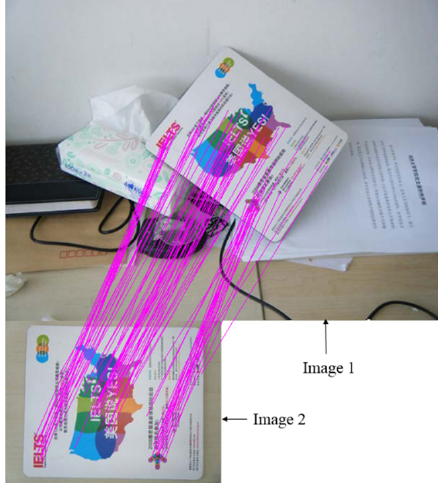
Figure 11. Same points detected by SIFT with two different images.